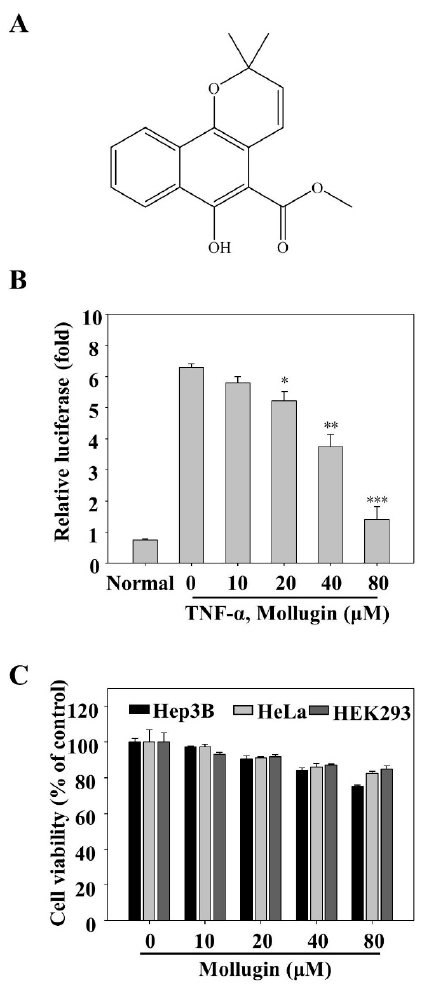
Figure 1. Mollugin inhibits the TNF- α -induced NF- κ B-dependent reporter gene expression. ( A ) Molecular structure of mollugin; ( B ) HeLa cells were transiently co-transfected with a pNF- κ B-Luc plasmid for 24 h, followed by pretreatment with mollugin for additional 12 h. Then, the cells were stimulated for 12 h with TNF- α (10 ng/mL), and the luciferase activity was determined, as previously mentioned, in “materials and methods”. Data represented as mean ± SD from three replicates, * p < 0.05; ** p < 0.01; *** p < 0.001 compared to the control group; ( C ) HeLa, Hep3B, and HEK293 cells were treated with different concentrations of mollugin, as shown in the figure. After 24 h incubation, cell viability was measured by MTT assay. Representative data from three independent experiments with similar outcomes is shown.